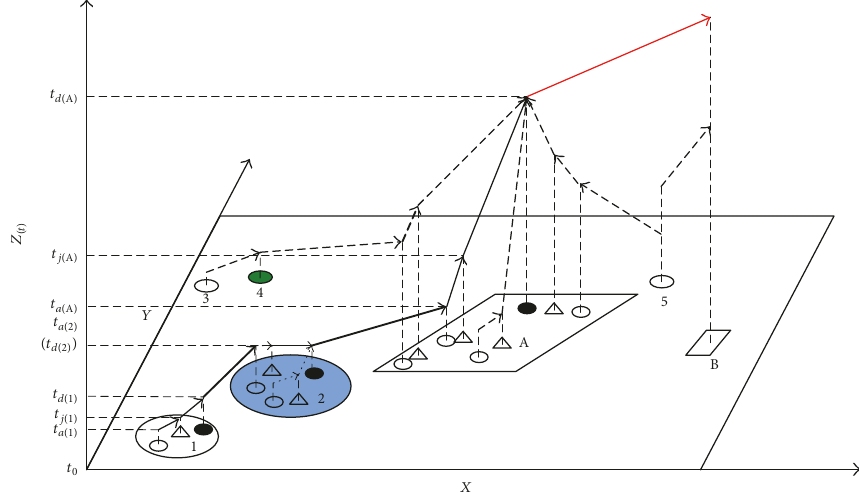
Figure 3: Example of time-space